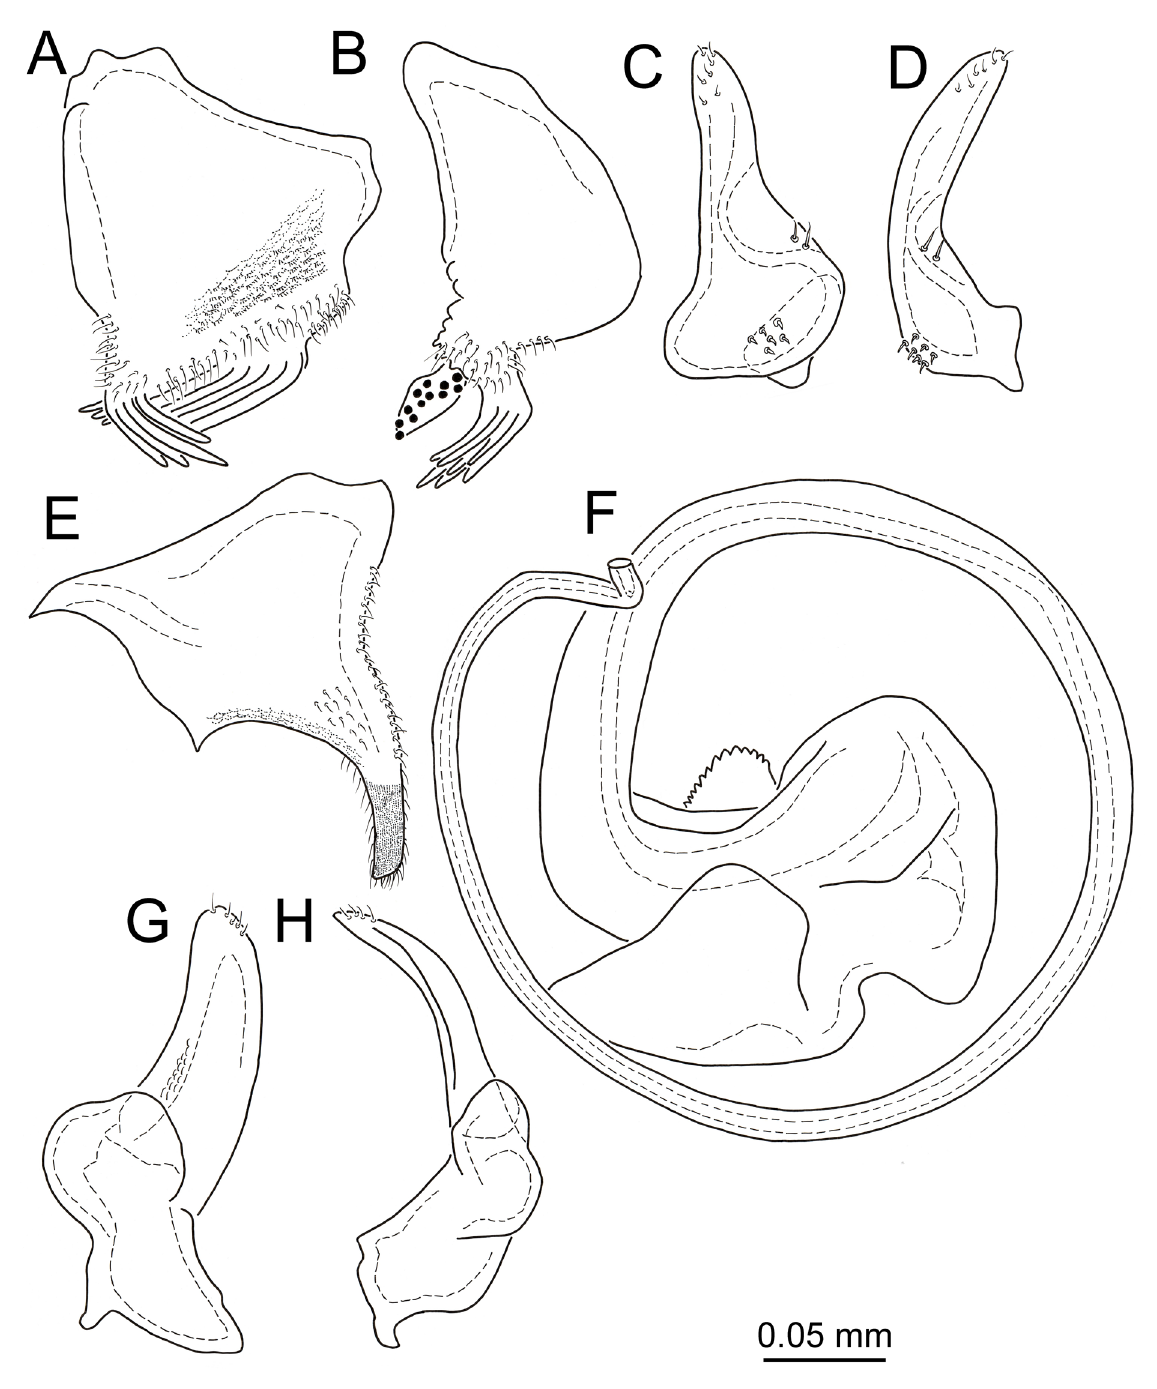
Fig. 12. Kokeshia hill i sp. nov., segment VIII and genitalia, paratype, ♂ (SYSBM). A‒B . Left hemitergite VIII. A . Dorsal view. B . Left lateral view. C‒D . Right paramere, two different aspects. E . Right hemitergite VIII, dorsal view. F . Phallus. G‒H . Left paramere, two different